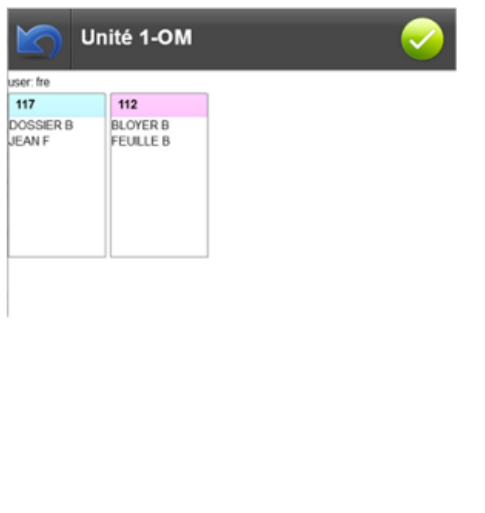
Figure 8. Screen for the selection of the rooms in the care unit.